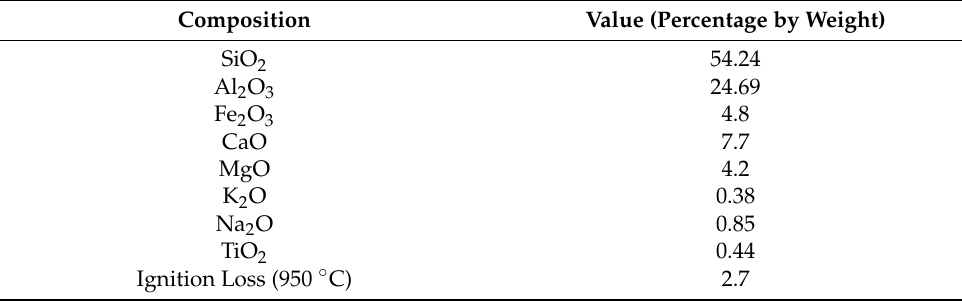
Table 2. Chemical composition of fly ash. Table 3. Parameters of the polypropylene fiber.